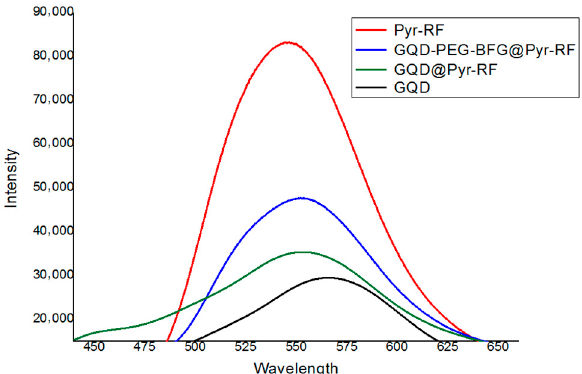
Figure 4. PL spectra of GQD (black line), GQD@Pyr-RF (green line), GQD-PEG-BFG@Pyr-RF (blue line), and Pyr-RF (red line) in water, at the excitation wavelength of 360 nm. The samples were tested at a concentration of 100 ng/mL.